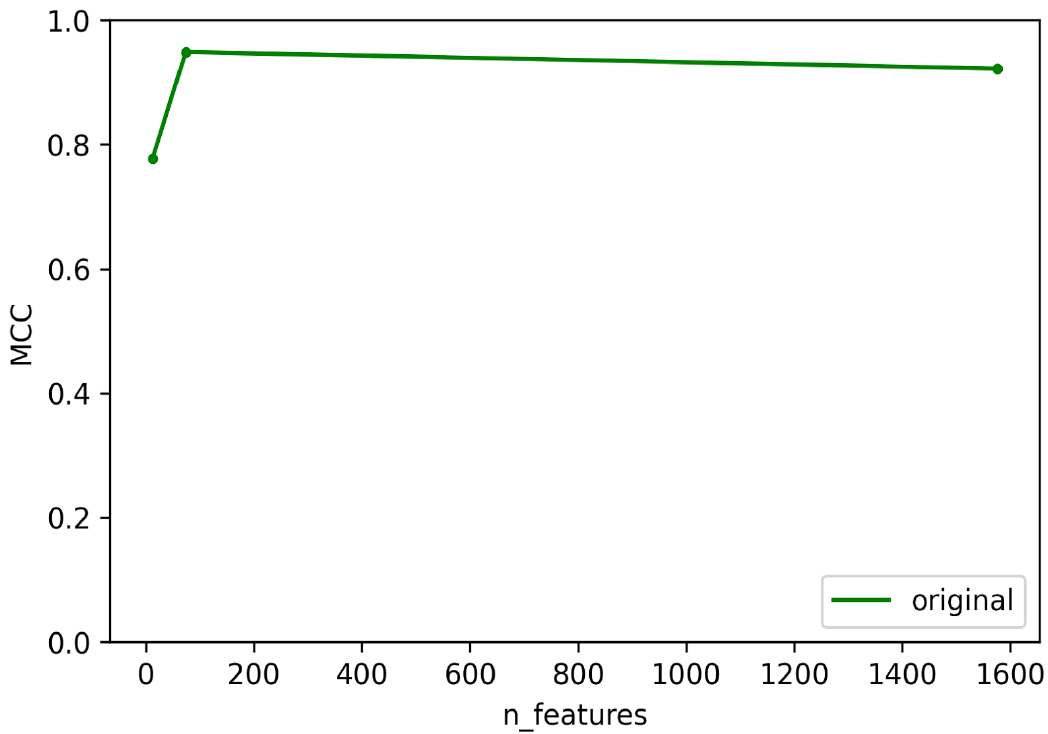
Figure 5. Test MCC of ParA predictor using original dataset and filtered datasets using different numbers of features.